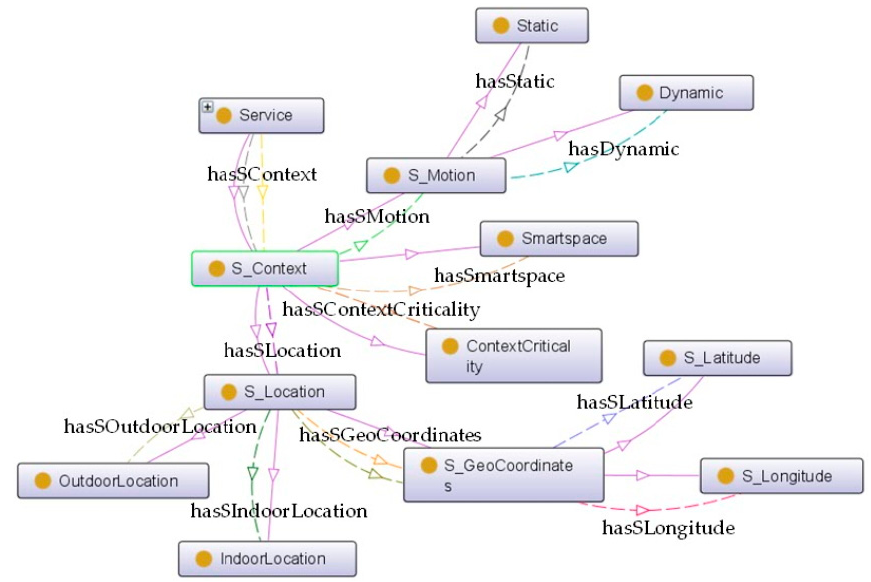
Figure 7. Internal structure of S_Context.